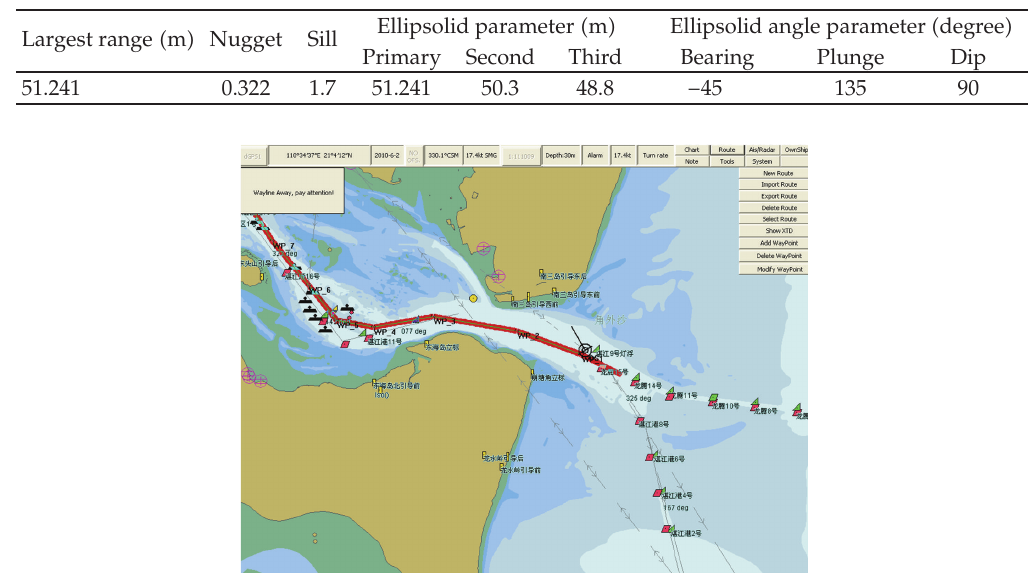
Table 1: The parameter of variogram.